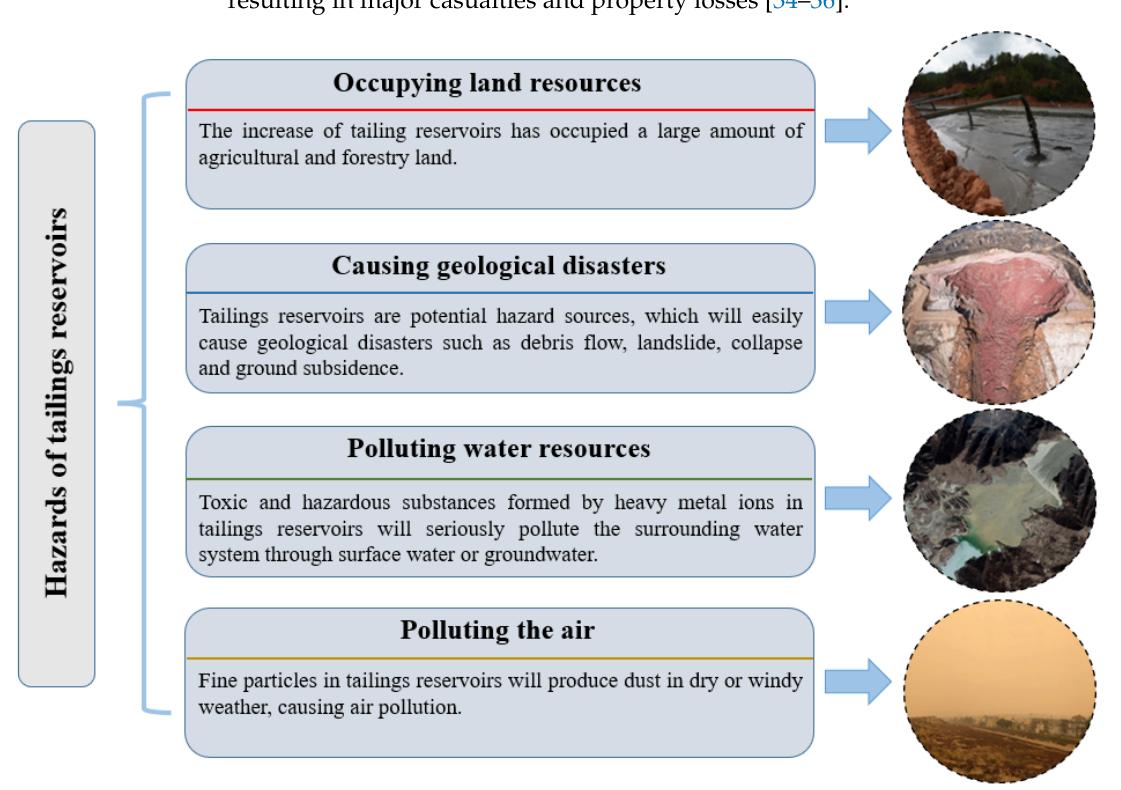
Figure 1. Adverse effects of tailings reservoirs on environment and human society.